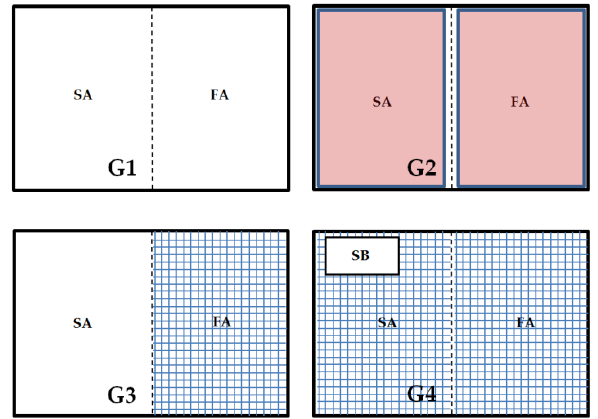
Figure 1. Characteristics of flooring designs: G1 = entire floor pen covered with litter (wood shavings); G2 = floor pen covered with litter and having floor heating (in red); G3 = partially (50:50)-slatted flooring (in blue) including an area with litter; G4 = fully-slatted flooring with a sand bath (900 cm 2 ). SA = scratching area, FA = feeding area, SB = sand bath.